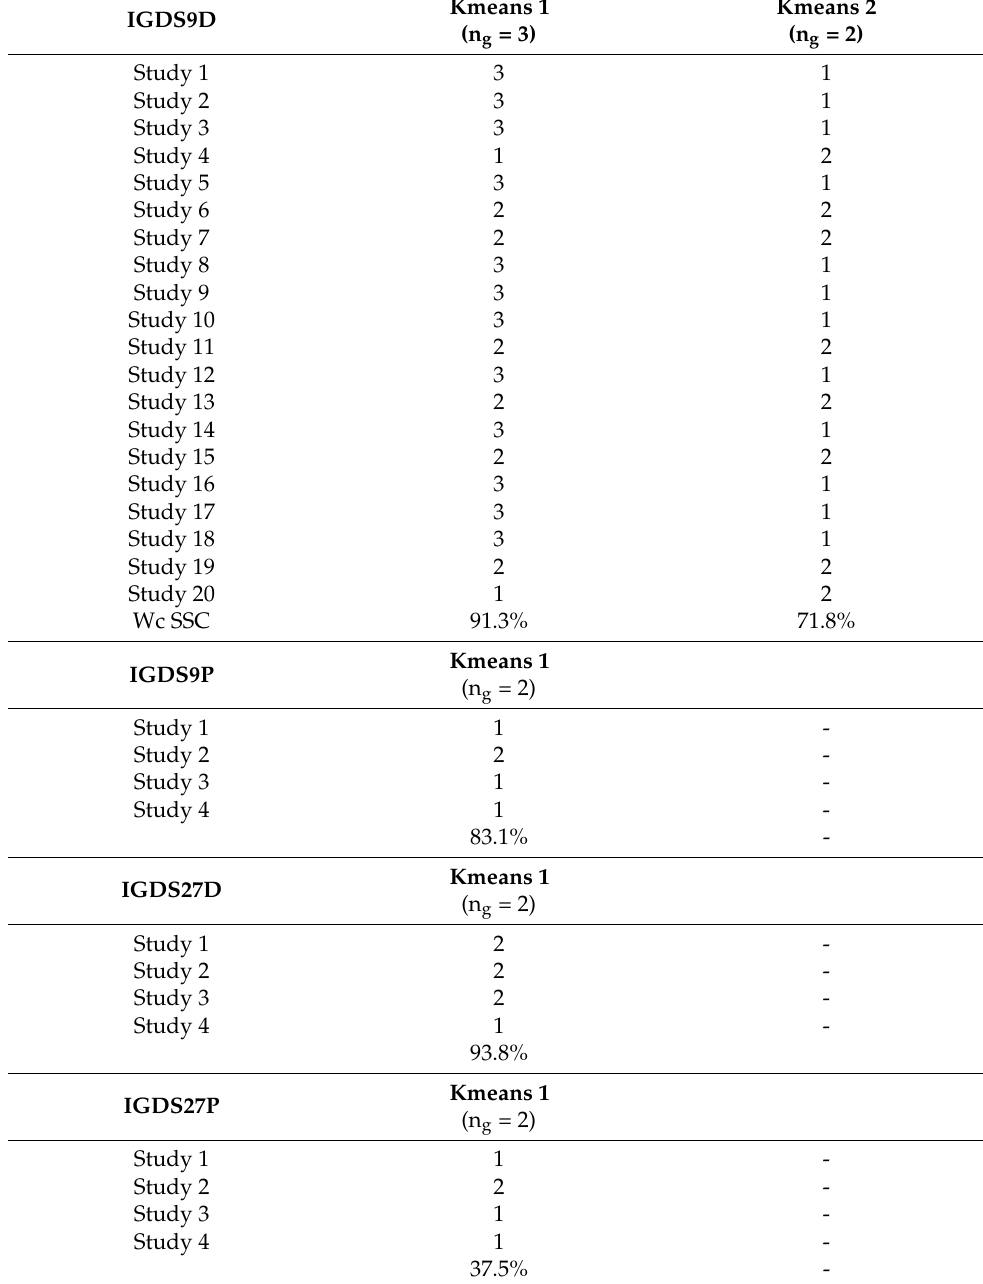
Table 3. Exploratory analysis